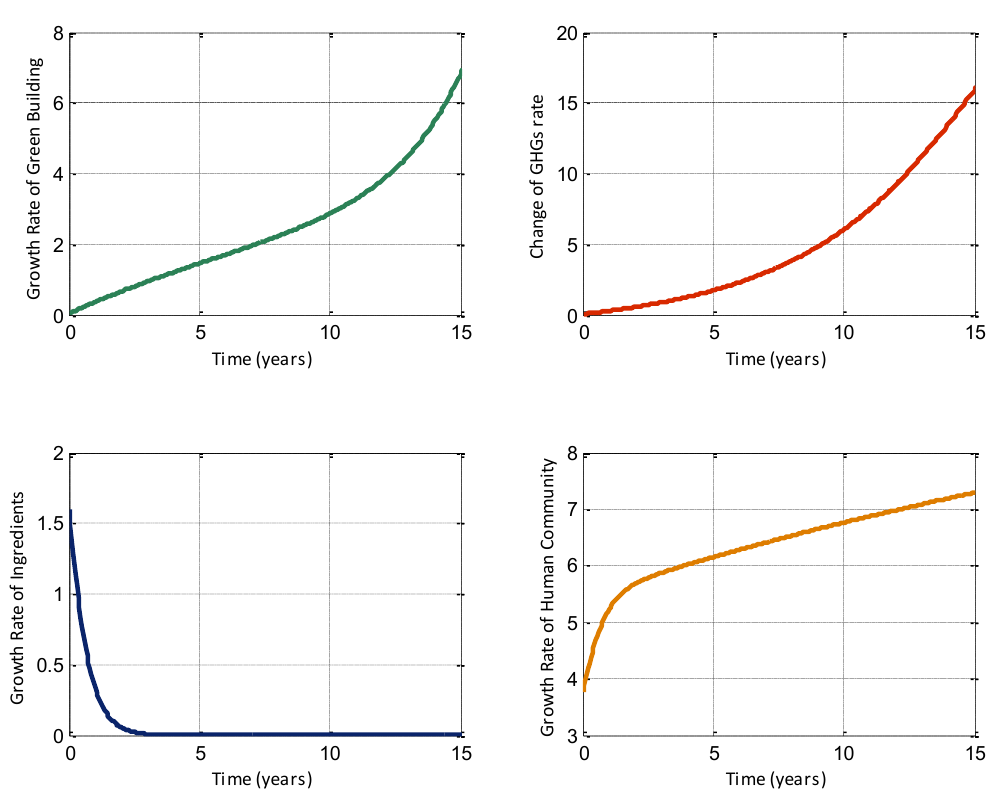
Figure 5 . Numerical behaviours of the dynamic variables of the model (1)-(4) over time.